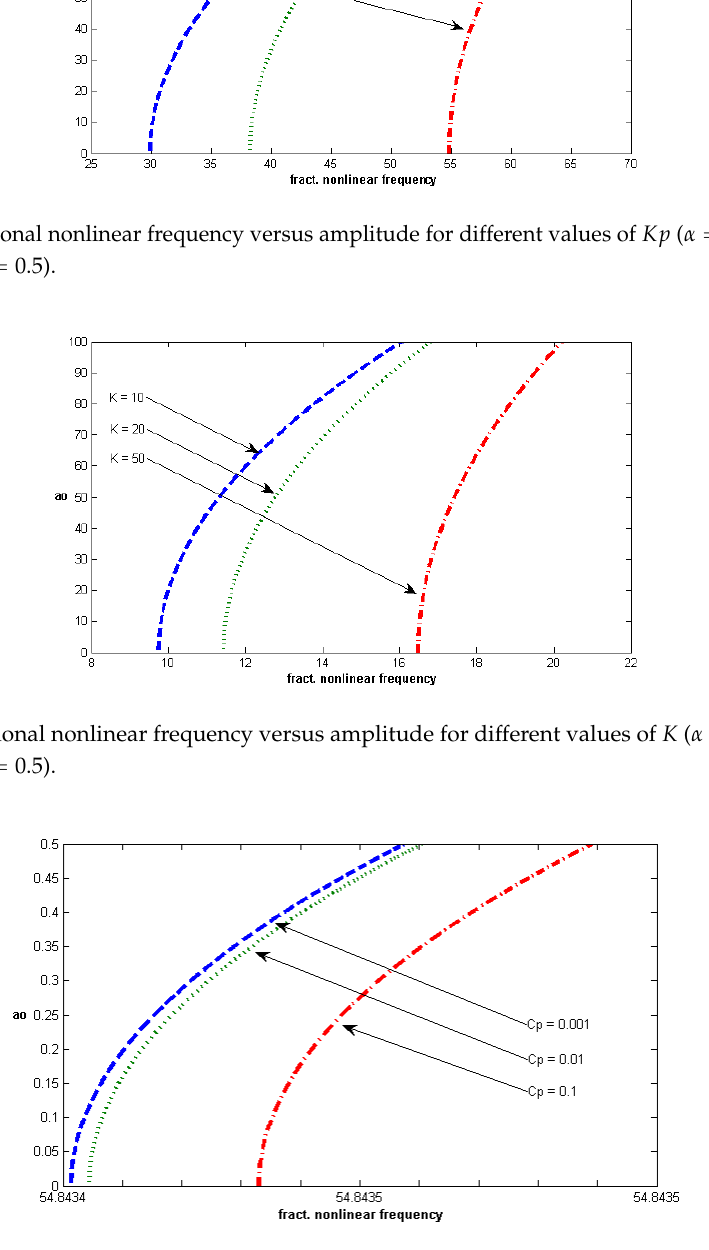
Figure 8. Fractional nonlinear frequency versus amplitude for different values of Cp ( α = 0.5, Kp = 5, K = 100, η =